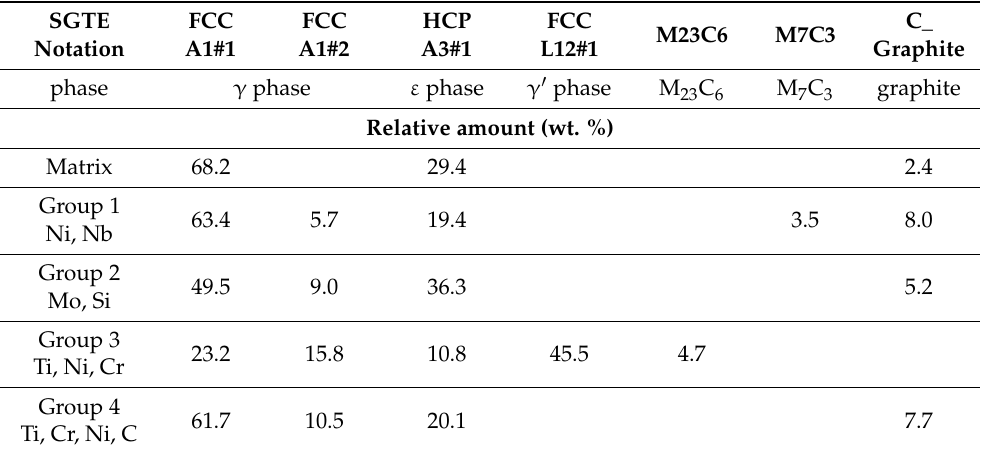
Table 3. Calculated relative amounts of phases that can be formed at equilibrium conditions at temperature 800 ◦ C for the chemical compositions of the matrix and designated groups of precipitates in the specimen annealed at 800 ◦ C for 500 h given in Table